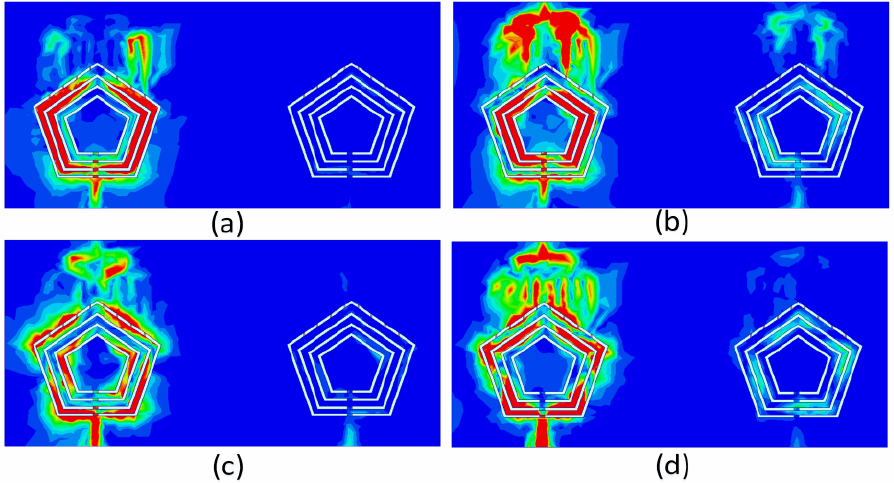
Figure 11. Current density distribution: ( a ) Ant-1 at 1.98 GHz, ( b ) Ant-1 at 2.69 GHz, ( c ) Ant-1 at 3.6 GHz, ( d ) Ant-1 at 4.25 GHz .